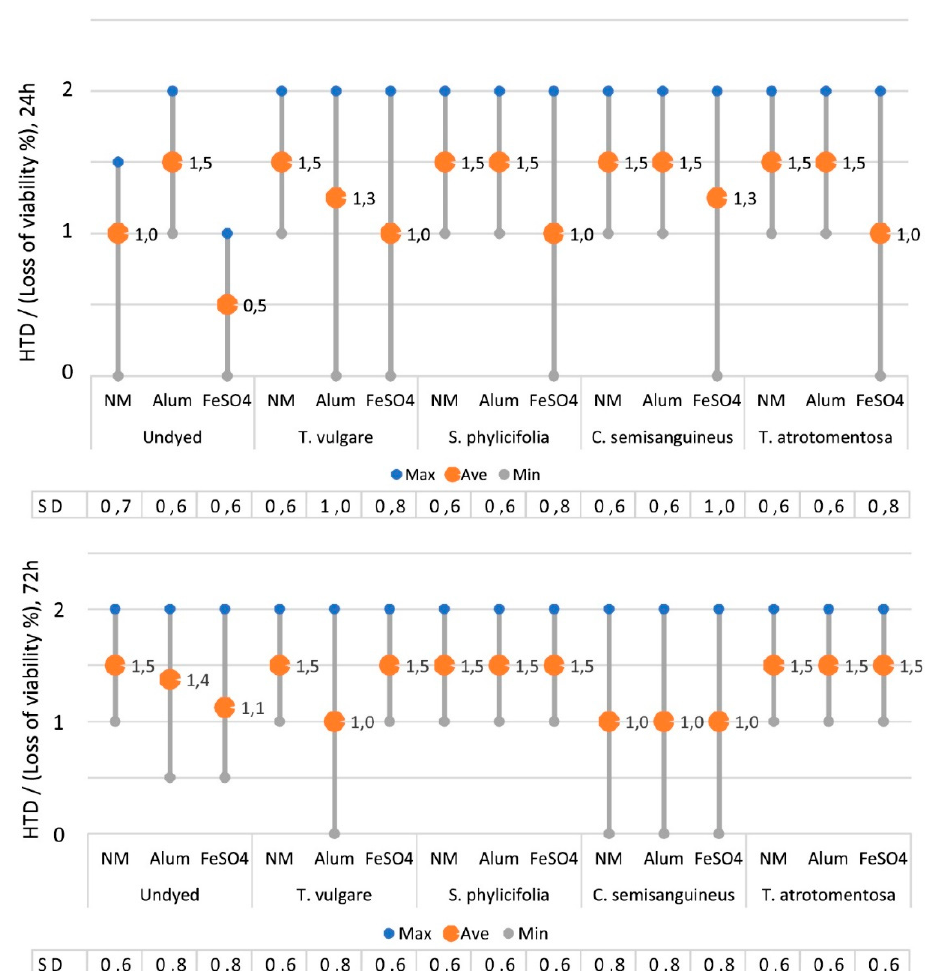
Figure 4. The effect of dye source, mordant and time on the HTD values (changes in morphology and loss of viability%) after 24 h (above) and 72 h (below) exposure times. EtOH dilutions of 1% and 2% are included (n = 152). NM = no mordant, SD = standard deviation.